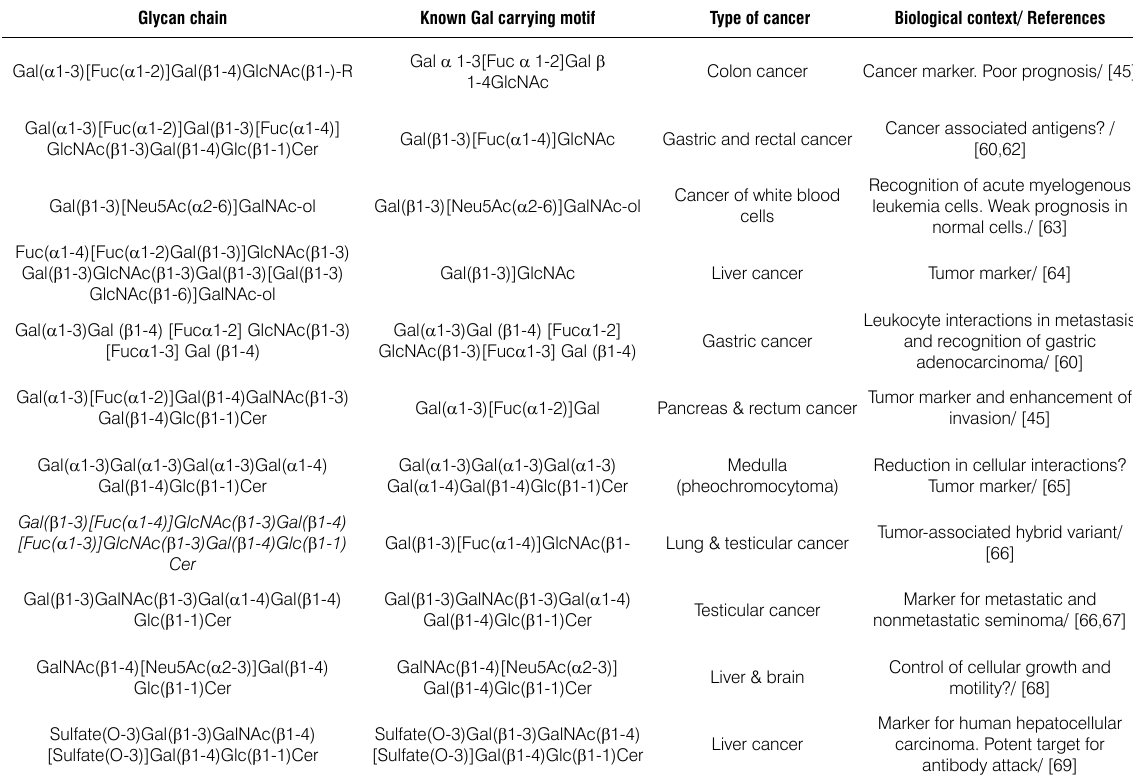
Table 2. Biological significance of Gal in malignant transformation and tumor